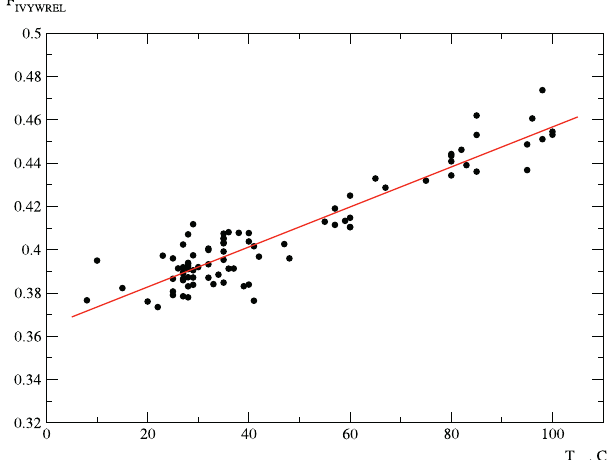
Figure 1. Correlation between the Sum F of Fractions of Ile, Val, Tyr, Trp, Arg, Glu, and Leu (IVYWREL) Amino Acids in 86 Proteomes and the OGT of Organisms T opt The linear regression (red line) corresponds to the correlation coefficient R ¼ 0.93. The OGT T opt (in degrees Celsius) can be calculated from the total fraction F of IVYWREL in the proteome according to T opt ¼ 937 F -335. By construction, the IVYWREL set is the most precise predictor of OGT among all possible combinations of amino acids; other combinations statistically yield a larger error of prediction of